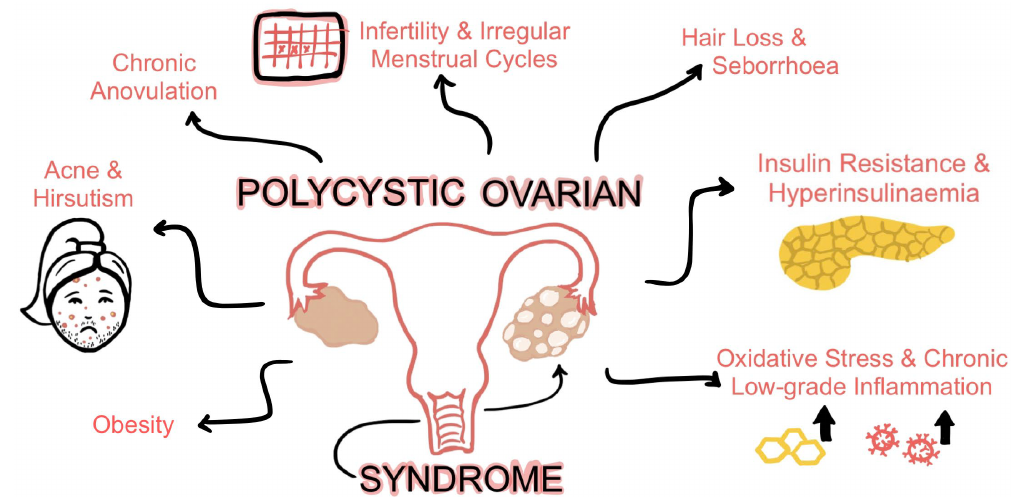
Figure 1. The clinical manifestations of PCOS in women.